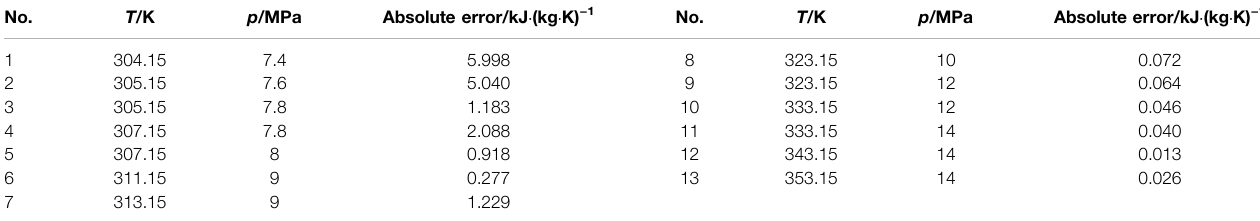
TABLE 5 | Absolute error of isobaric speci fi c heat calculation in the pseudocritical region.